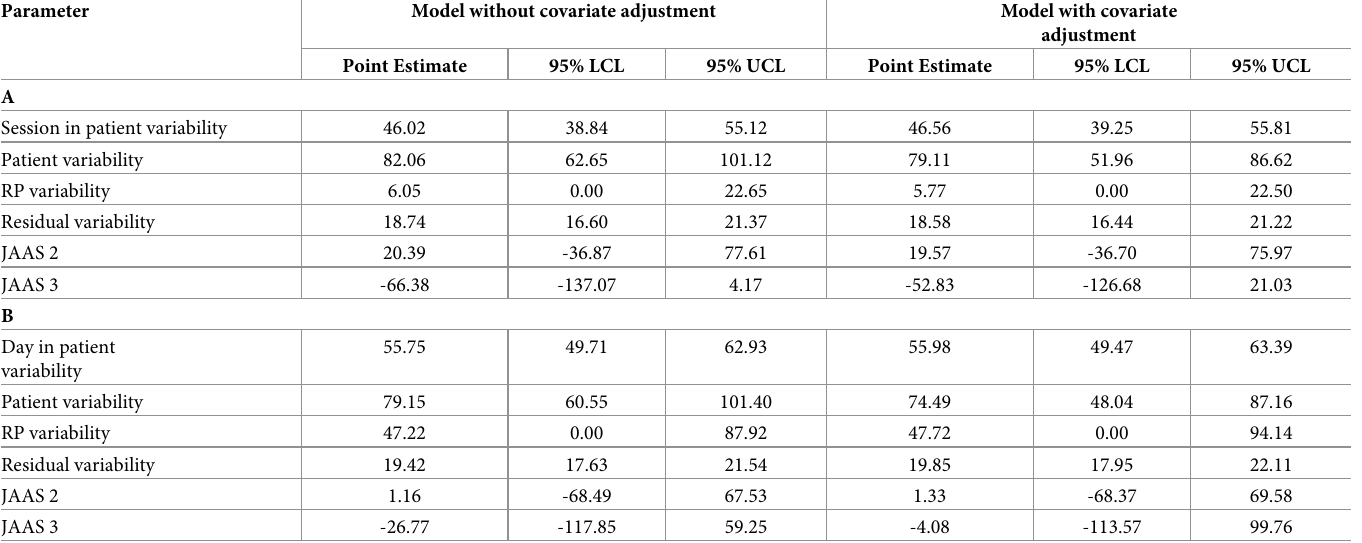
Table 2. Variability profile for AE “number of hits”. Table 2 : Part A : Point estimates and 95% confidence intervals for the standard deviations of the random effect terms and the regression coefficients of the JAAS machine relative to JAAS 1 in the ‘day 1’ model of the ‘Number of hits’. (LCL: lower confidence limit; UCL: upper confi- dence limit). Table 2: Part B : Point estimates and 95% confidence intervals for the standard deviations of the random effect terms and the regression coefficients of the JAAS machine relative to JAAS 1 in the longitudinal model of the ‘Number of hits’. (LCL: lower confidence limit; UCL: upper confidence